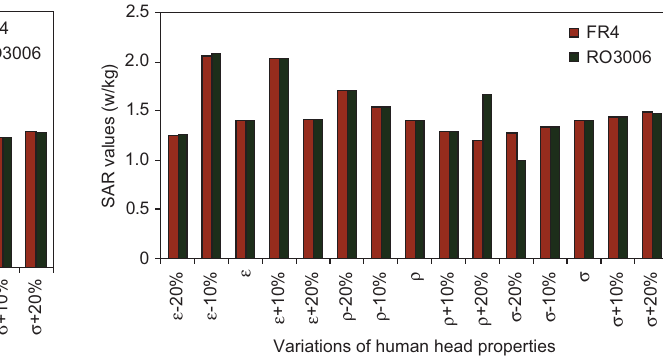
Figure 9 SAR 10 g of two different substrates at 900 MHz.